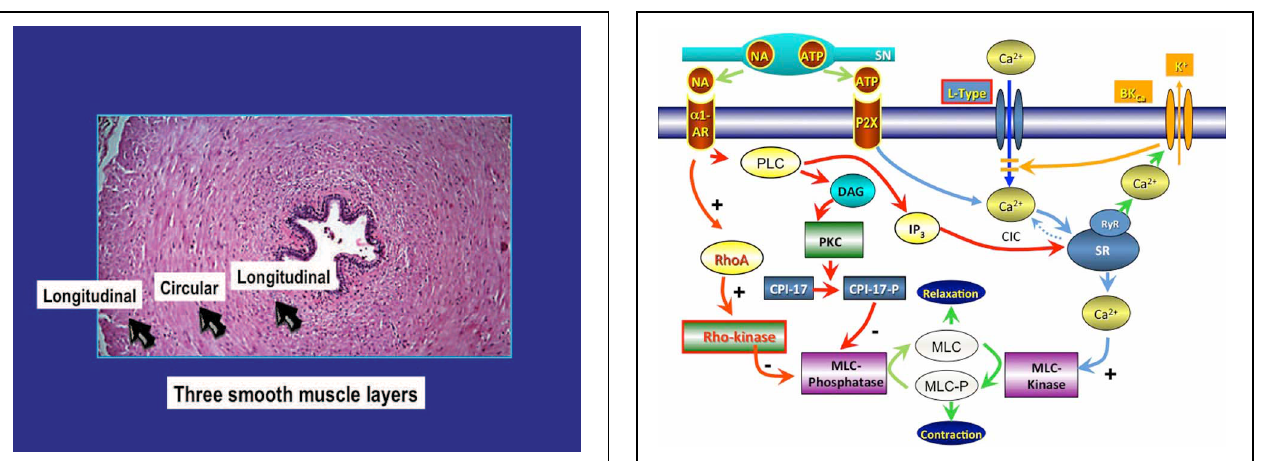
FIGURE 1 | Structure of the human vas deferens. sal root ganglia (Kaleczyc, 1998; Kihara et al., 1998; Burnstock